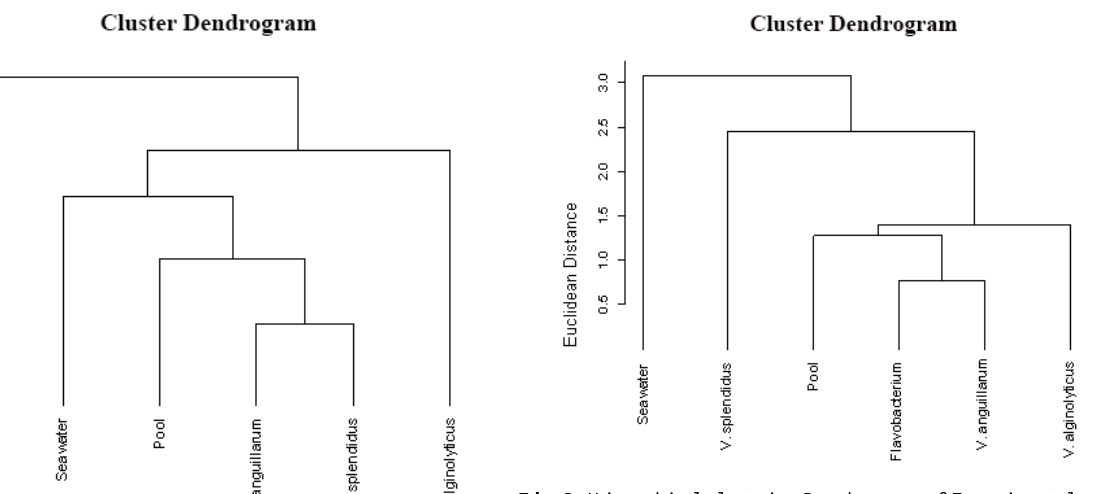
Fig. 3. Hierarchical clustering Dendrogram of Experimental con- dition ( Flavobacterium , pool of Vibrios, V. anguillarum , V. splen- didus , V. alginolyticus ) and Control (Seawater) of mussel B. azori- cus at 24h post-infection through Euclidean distance, using UP- GMA method.